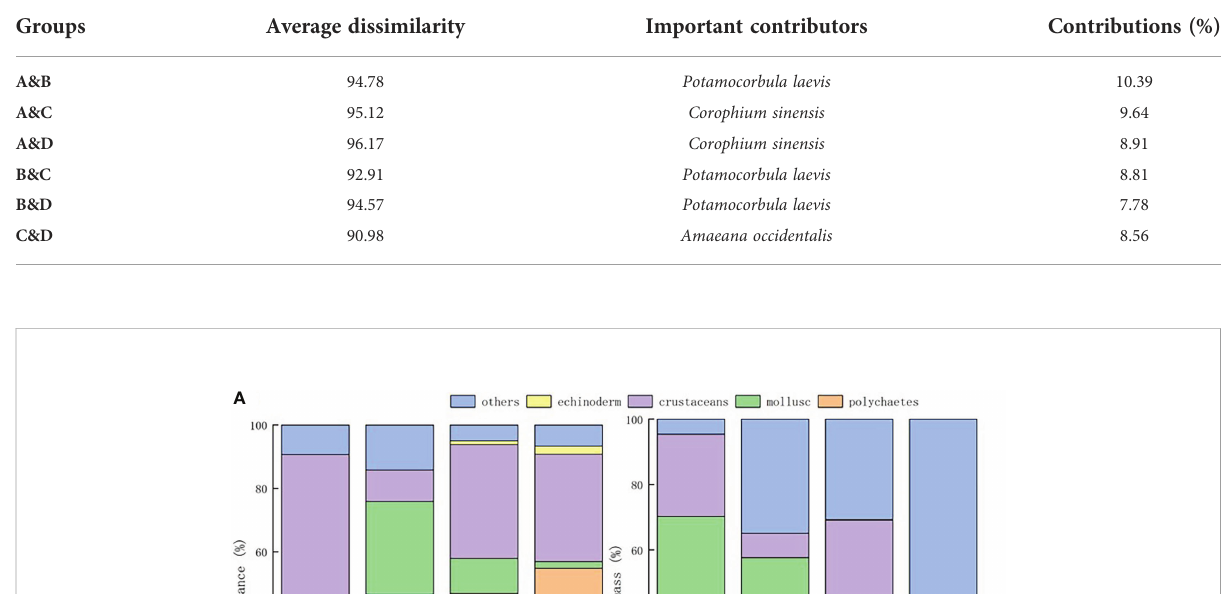
highest, with the most-abundant species being Magelona cincta , Sternaspis chinensis , and Amaeana occidentalis . In region C, polychaetes, especially S. chinensis , also contributed most to biomass. Kruskal – Wallis tests revealed signi fi cant differences (P< 0.05) in macrobenthos abundance and biomass between region